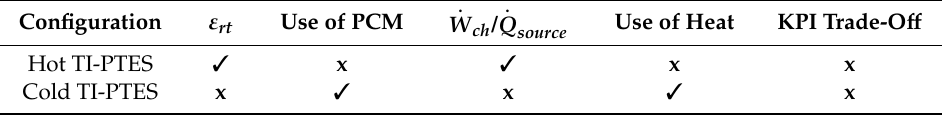
Table 3. Qualitative comparison between “hot TI-PTES” and “cold TI-PTES”. The tendency of a configuration to deal with the related issue positively is marked with a (cid:51) . Alternatively, an x is used.